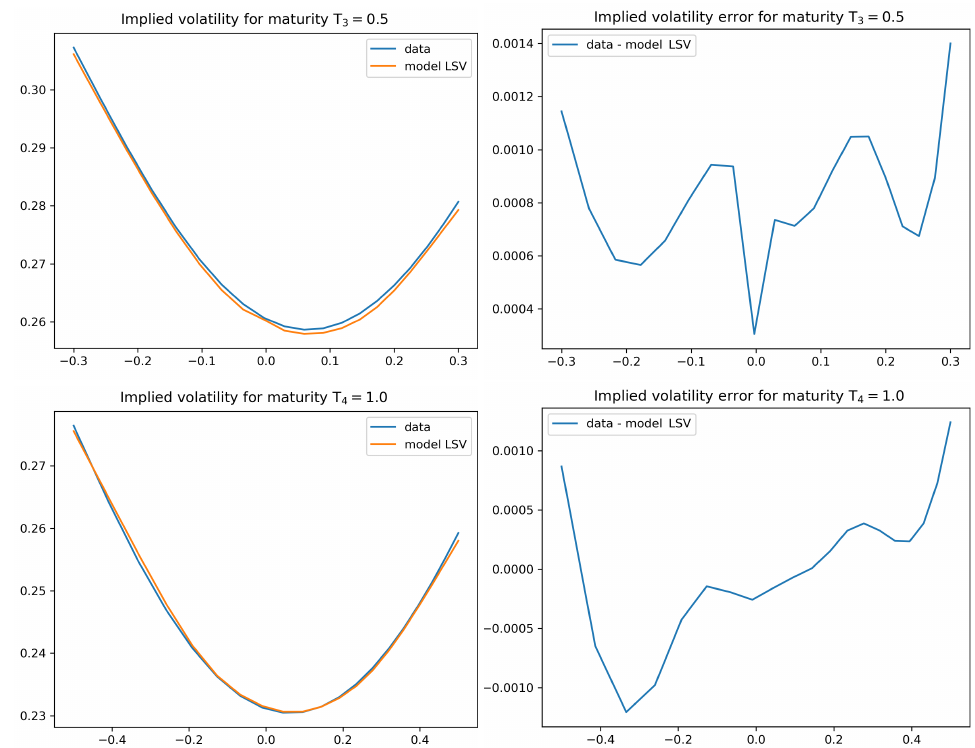
Figure 3. Left column: implied volatilities for the calibrated model together with the data (synthetic market) implied volatilities for a typical example of a synthetic market sample for all available maturities. Right column: calibration errors by subtracting model implied volatilities from the data implied volatilities. The x -axis is given in log-moneyness ln ( K / S 0 ) .